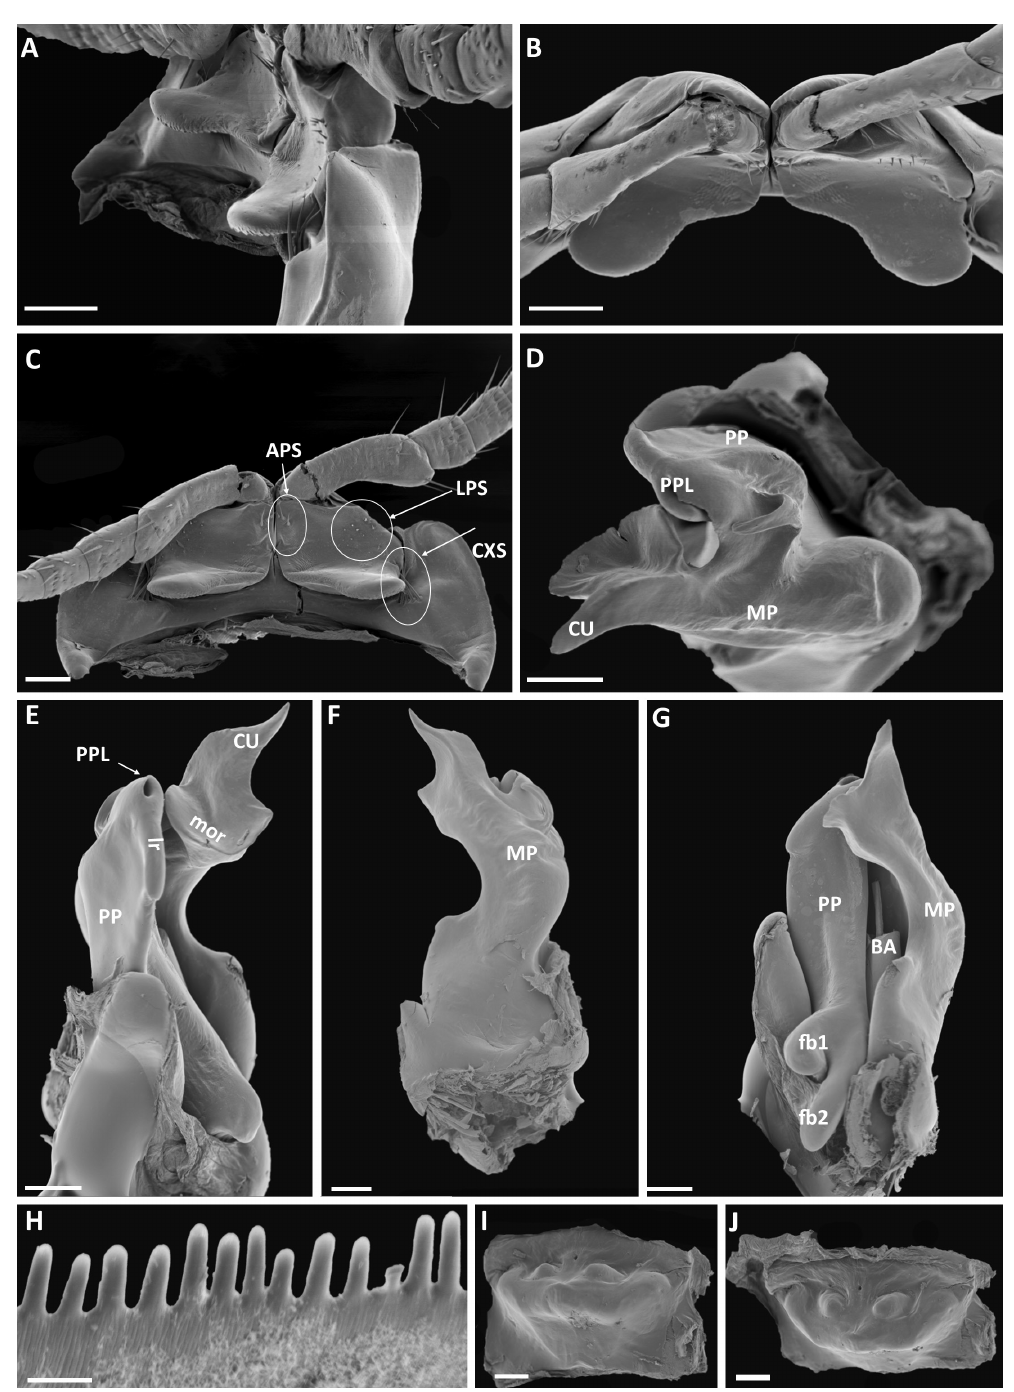
Fig. 69. Xystopyge hippocampus sp. nov., holotype, ♂ (NHMD 621770). A – C . First pair of legs. A. Sublateral view. B. Ventral view. C. Anterior view. D – G . Left gonopod coxa. D. Apical (ventral) view. E. Anterior view. F. Posterior view. G. Mesal view. H . Midbody dorsal limbus. I – J . Sternum 9. I. Posterior view. J. Subapical (subventral) view. Abbreviations: APS = mesapical prefemoral setae; BA = basomere of telopodite (broken); CU = cucullus; CXS = coxosternal setae; fb1 , fb2 = fingerlike proplical bulges; LPS = lateral prefemoral setae; lr = longitudinal proplical ridge; mor = metaplical oblique ridge; MP = metaplica; PP = proplica; PPL = proplical lobe. Scale bars. A–G, I–J = 0.2 mm; H = 0.01